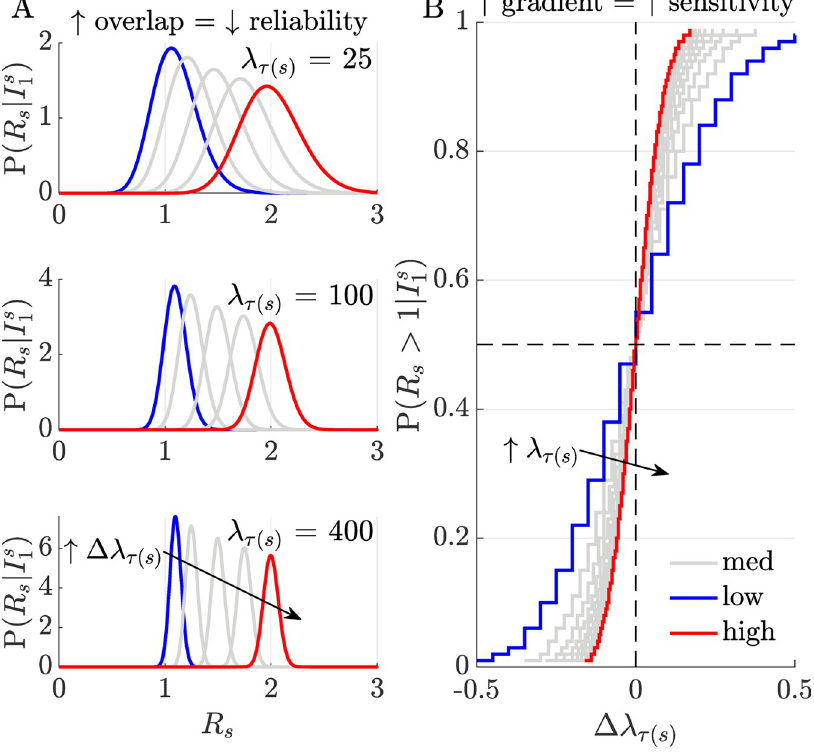
Fig 1. Relative sensitivity to perturbations in incidence. Panel A plots posterior real-time distributions for time- varying reproduction numbers R s , given incidence data I s , at different relative incidence perturbations, D l ¼ t ð s Þ 1 i t ð s Þ (cid:0) l t ð s Þ ; (increasing from blue to red). Here τ ( s ) represents some arbitrary window size used in computation (see Eq l t ð s Þ (2) ). The degree of distribution separation and hence our ability to uncover meaningful incidence fluctuations from (i.e., as this increases from 25–400 overlap among the distributions noise, improves with the current epidemic size, λ τ ( s ) decreases). Panel B shows how this sensitivity modulates our capacity to infer resurgence ( P ð R > 1 j I s Þ ) and control 1 s ( P ð R s (curves have steeper gradient as we traverse from blue to red). Resurgence (likely closer to the blue line in the top right quadrant) is appreciably and innately harder to detect than control (likely closer to the red line, in the bottom left